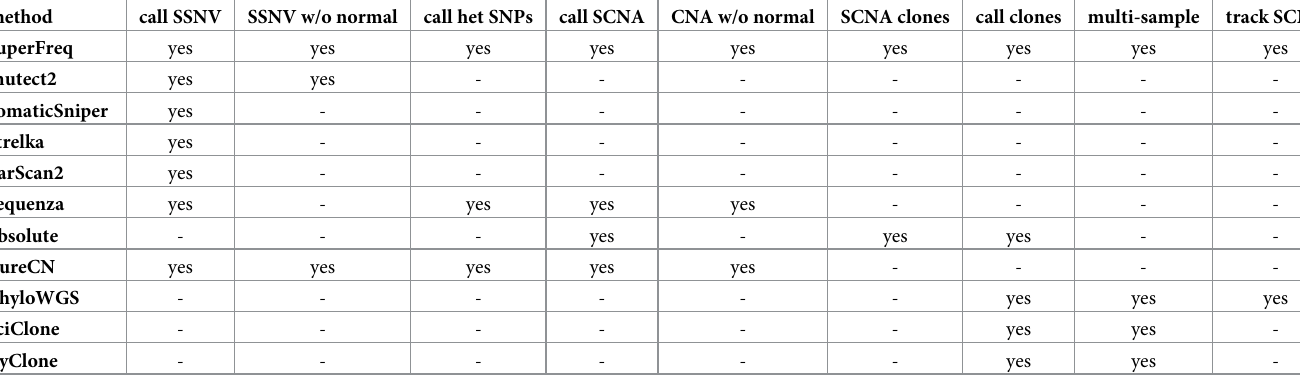
Table 1. Properties of other mutation callers and clonal trackers in comparison to SuperFreq.